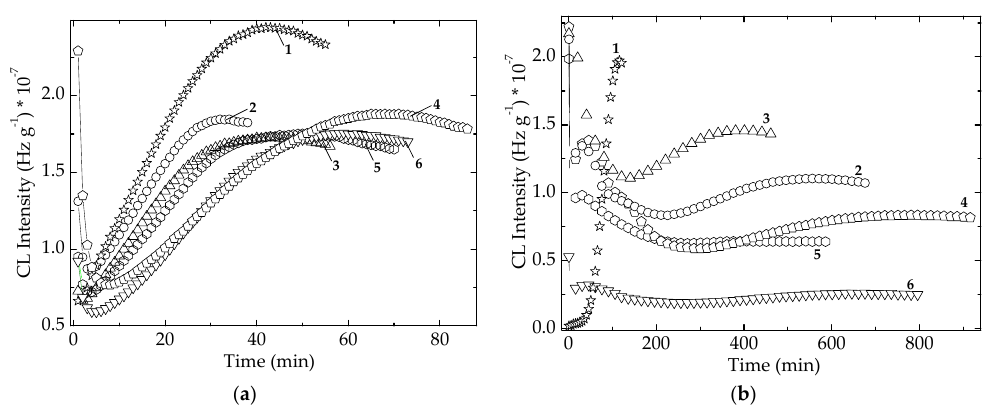
Figure 10. Isothermal spectra irradiated EPDM hybrids. ( a ) dose 25 kGy; temperature: 160 °C; ( b ) dose 100 kGy; temperature: 150 °C. (1) Neat polymer; (2) EPDM/Ov-POSS 5; (3) EPDM/ Chlorella vulgaris ; (4) EPDM/ Spirulina platensis ; (5) EPDM/Ov-POSS 5/ Chlorella vulgaris ; (6) EPDM/Ov-POSS 5/ Spirulina platensis .